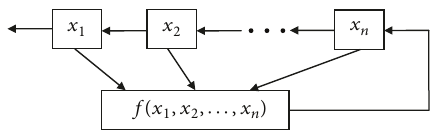
Figure 1: An 𝑛 -stage nonlinear feedback shift